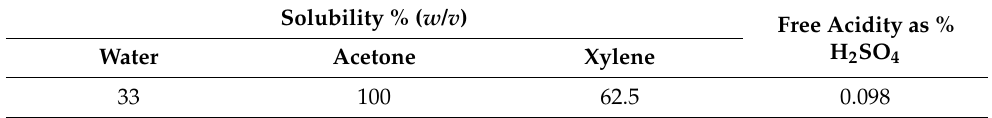
Table 1. Physico-chemical properties of phenol as an active